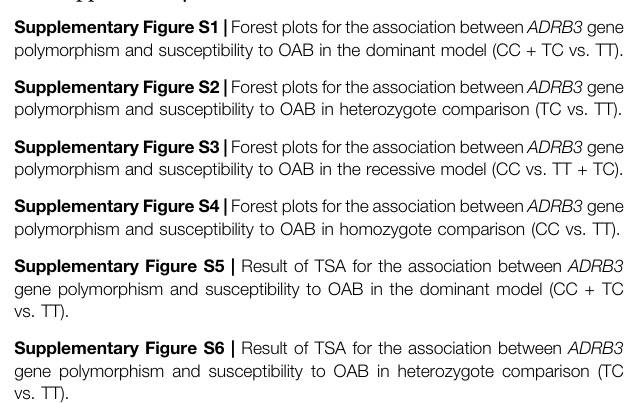
Supplementary Figure S4 | Forest plots for the association between ADRB3 gene polymorphism and susceptibility to OAB in homozygote comparison (CC vs. TT). Supplementary Figure S5 | Result of TSA for the association between ADRB3 gene polymorphism and susceptibility to OAB in the dominant model (CC + TC vs. TT). Supplementary Figure S6 | Result of TSA for the association between ADRB3 gene polymorphism and susceptibility to OAB in heterozygote comparison (TC vs. TT). Supplementary Figure S7 | Result of TSA for the association between ADRB3 gene polymorphism and susceptibility to OAB in the recessive model (CC vs. TT + TC). Supplementary Figure S8 | Result of TSA for the association between ADRB3 gene polymorphism and susceptibility to OAB in homozygote comparison (CC vs.